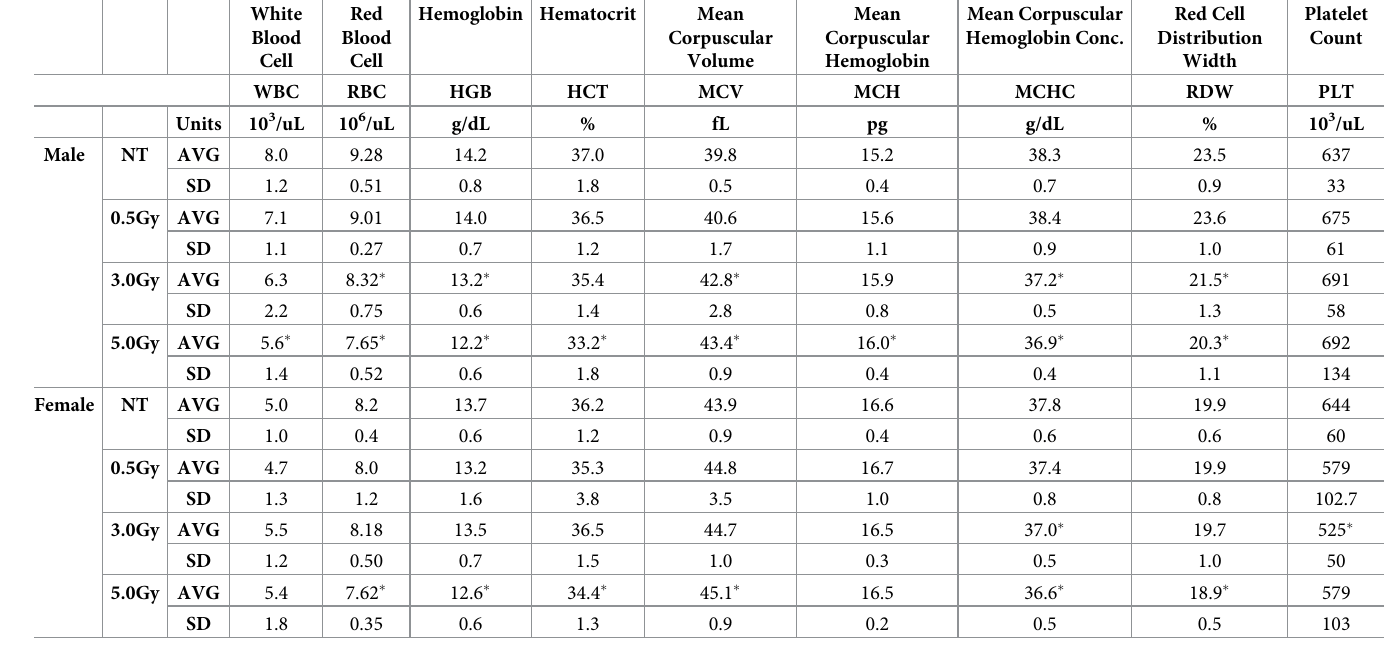
Table 2. Total body irradiation results in sustained complete blood count abnormalities, 52 weeks after